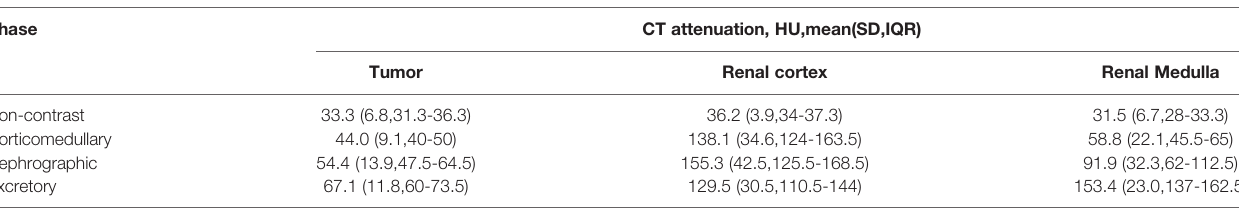
TABLE 4 | CT attenuation of the tumor, renal cortex and renal medulla. Phase